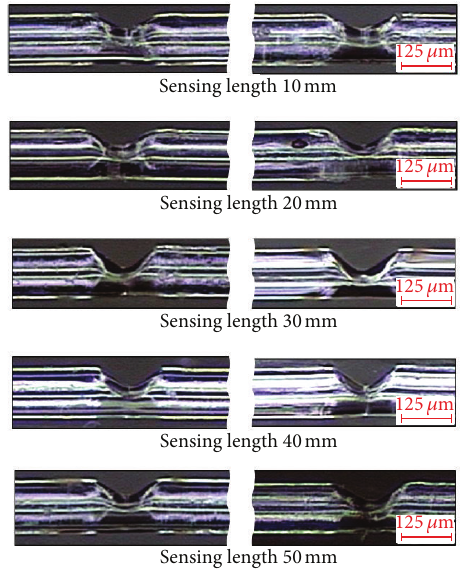
Figure 10: The image measurement results of various lengths.